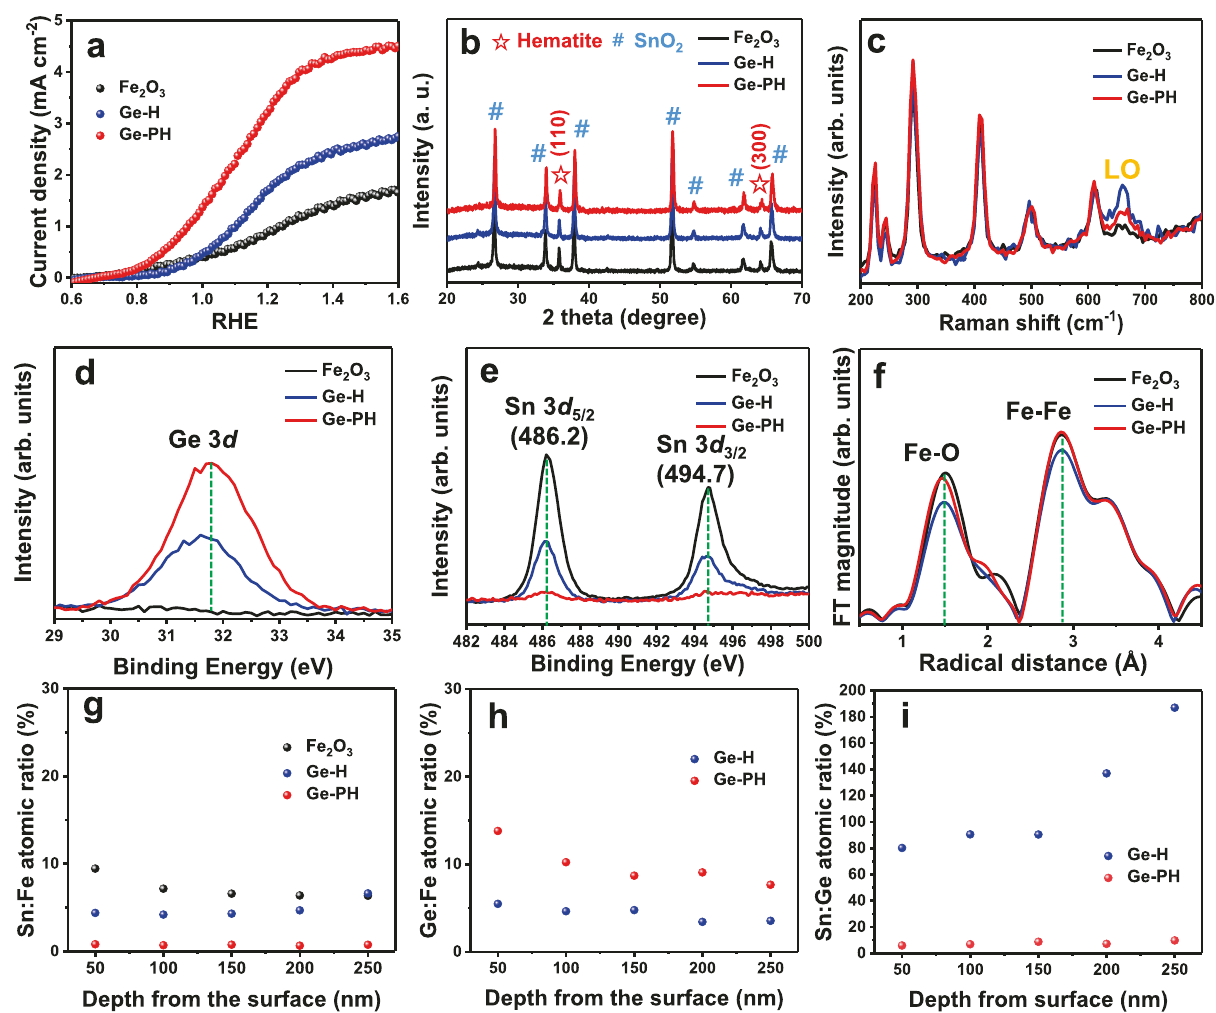
Fig. 2 The performance and structure analysis of various photoanodes. a Comparison of the photoelectrochemical performance of Fe 2 O 3 , Ge-H, and Ge-PH in a 1 M NaOH (pH = 13.6) electrolyte under simulated sunlight illumination (1 SUN). b Comparison of b) XRD patterns and c Raman spectra of Fe 2 O 3 , Ge-H, and Ge-PH. XPS spectra of d Ge 3d, and e Sn 3d. f Fourier transform of the EXAFS data at the Fe k-edge of the hematite nanostructures in Fe 2 O 3 , Ge-H, and Ge-PH. The XPS depth pro fi les of g Sn, h Ge, and i calculated Sn:Ge doping PEC water oxidation activity and characterization . Figure 2a